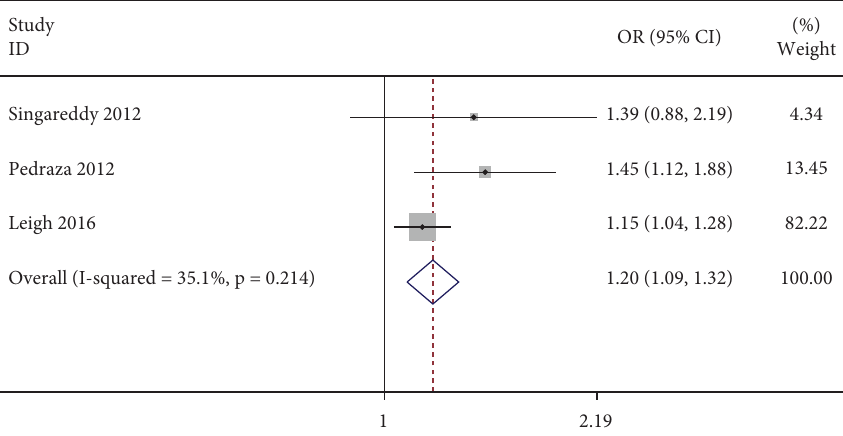
Figure 3: Forest plots of hypertension predicting incident insomnia. Squares represent the study-specifc relative risk. Diamonds represent the summary relative risks (SRRs). Horizontal lines represent 95% confdence intervals